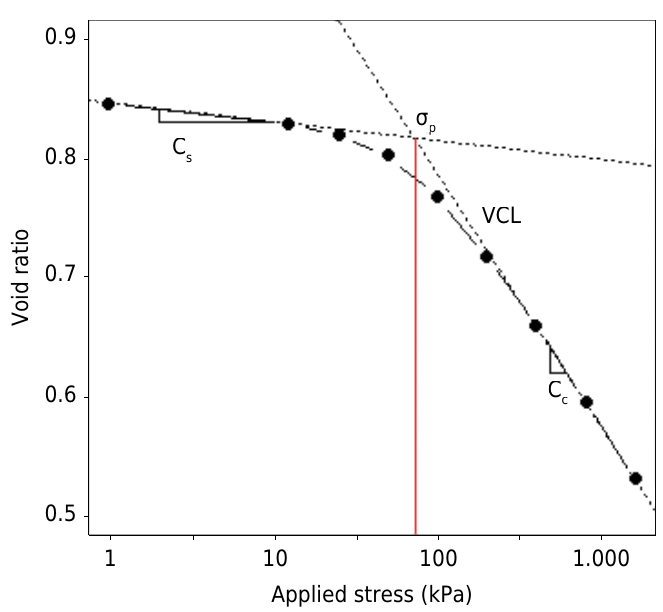
Applied Figure 1. Determination of precompression stress (σ p ) by reg1, regression method based on 2 points, expressed in terms of void ratio, as a function of the logarithm of applied stress (kPa); Virgin compression line (VCL); the slope of the VCL is denominated as the compressibility coefficient, C c ; swelling index, C s . Adapted from Keller et al. (2011).